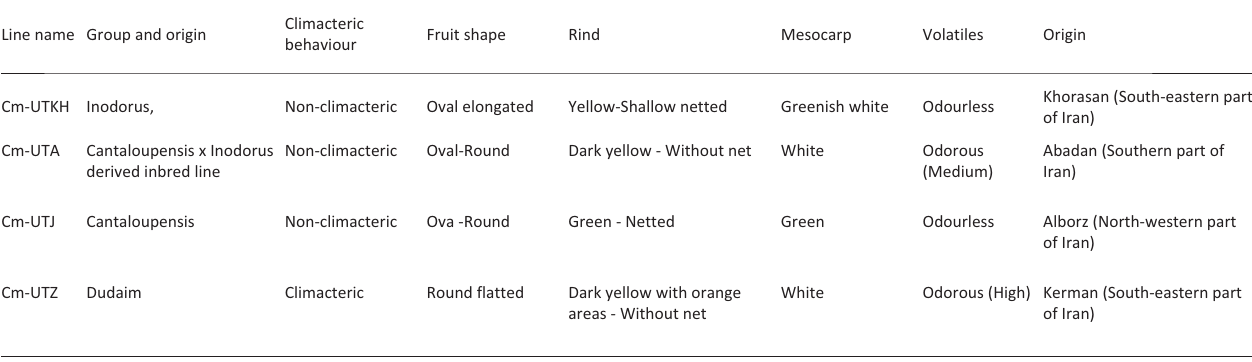
Table 1 ­ The morphological characterizations of the inbred lines used for the crosses Line name Group and